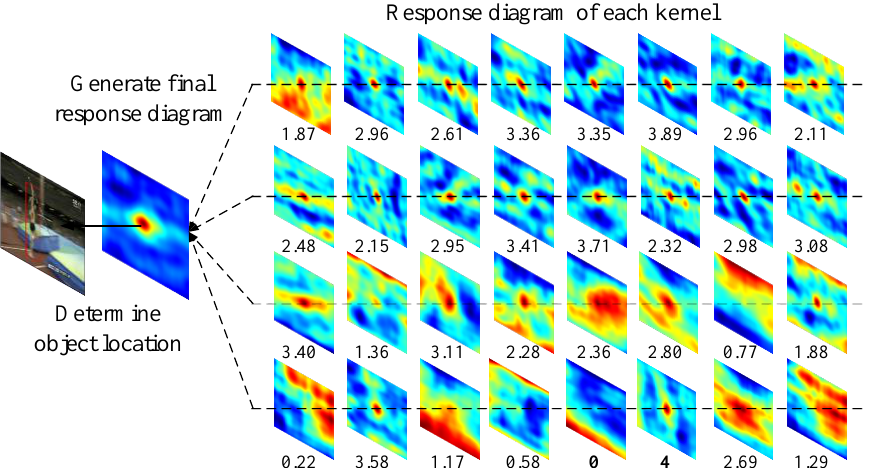
Figure 9. The proposed attention module weighting results for each convolution kernel ( “ jump ” video sequence).